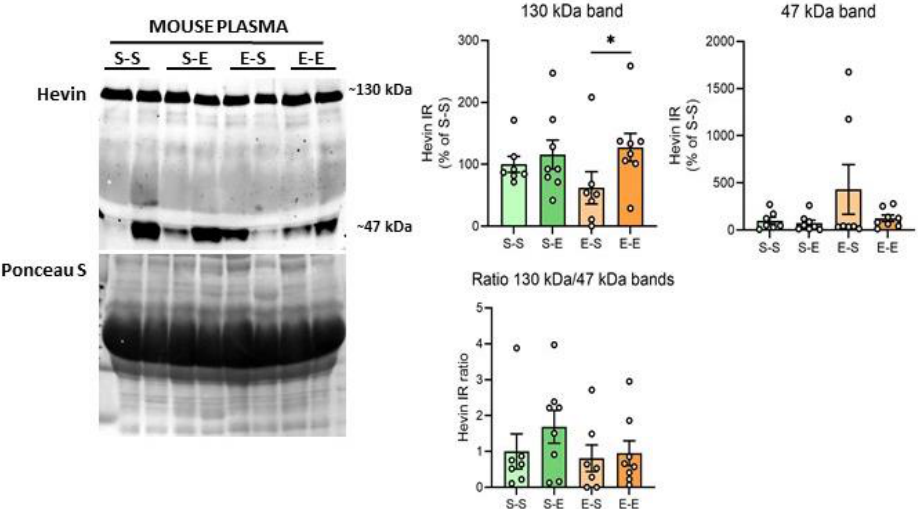
Figure 4. Hevin protein expression in mouse plasma after different regimens of ethanol . A rep- resentative Western blot of hevin in mouse plasma and its Ponceau S stain images, along with the graphics representing the actin-normalized immunoreactivity of the ~130 kDa and ~47 kDa hevin bands and the 130 kDa/47 kDa band ratio in the four treatment groups (S – S: saline – saline, S – E: